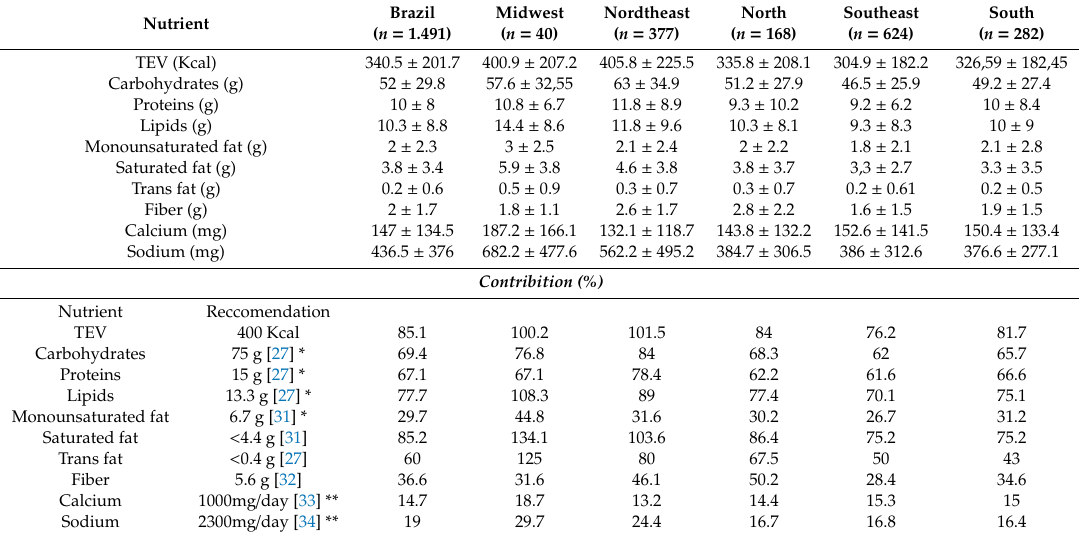
Table 4. Mean and standard deviation of the low-income population’s ingestion of nutrients during breakfast by Brazilian